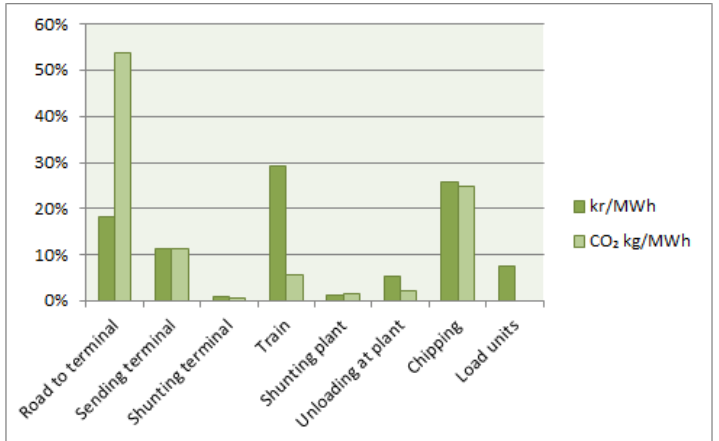
Figure 15. Distribution of costs and CO 2 emissions with intermodal transhipment for the base